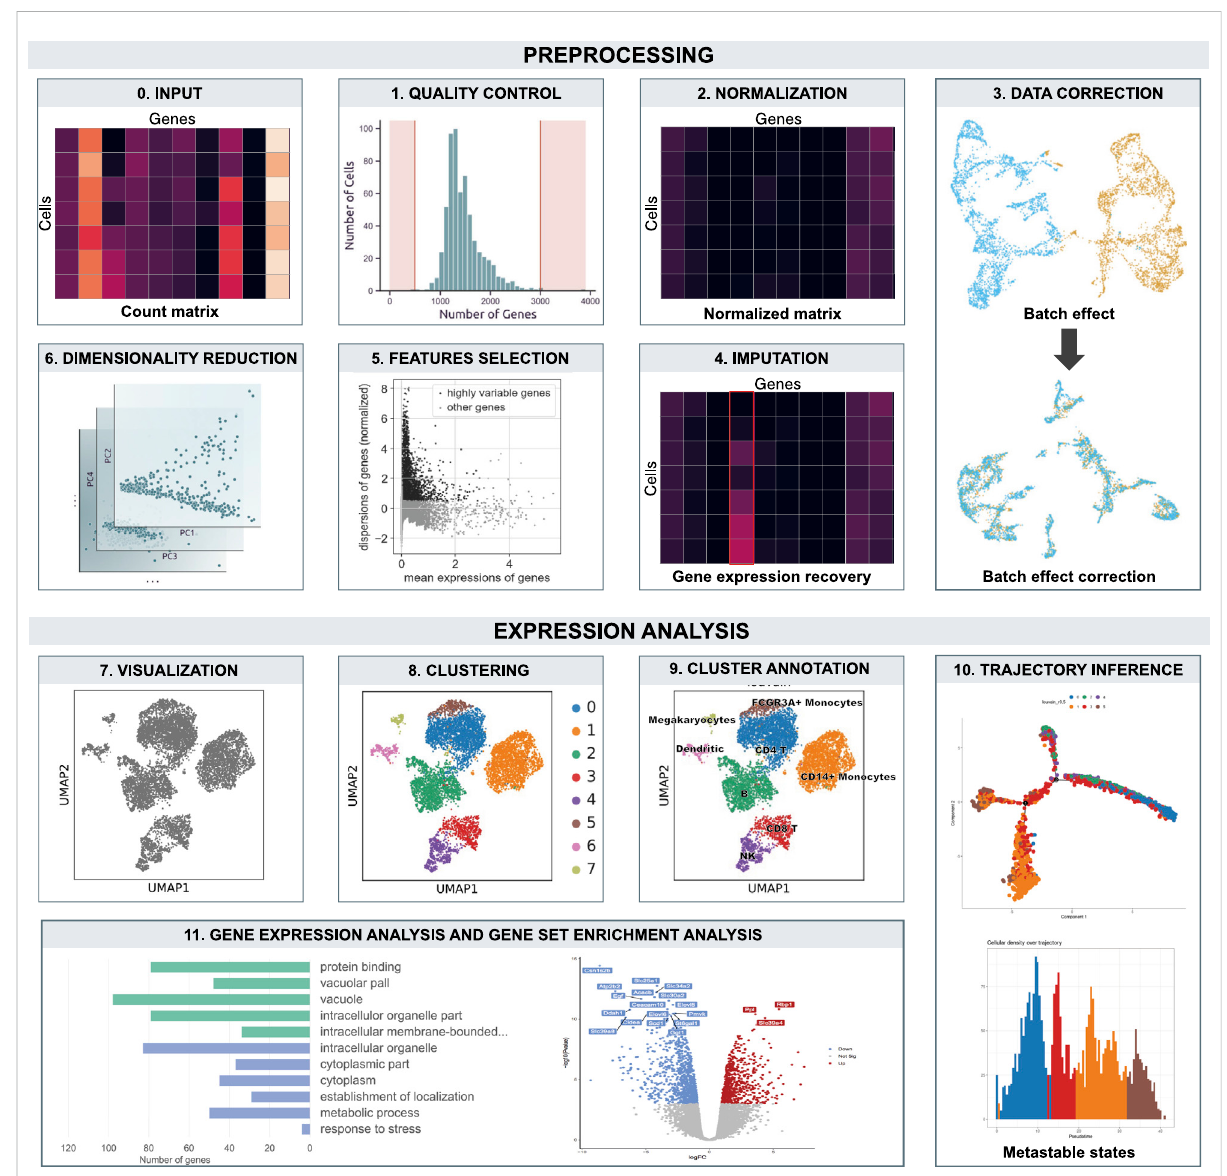
FIGURE 2 Overview of the work fl ow. The count matrix undergo preprocessing and expression analysis. Boxes are ordered according data analysis fl